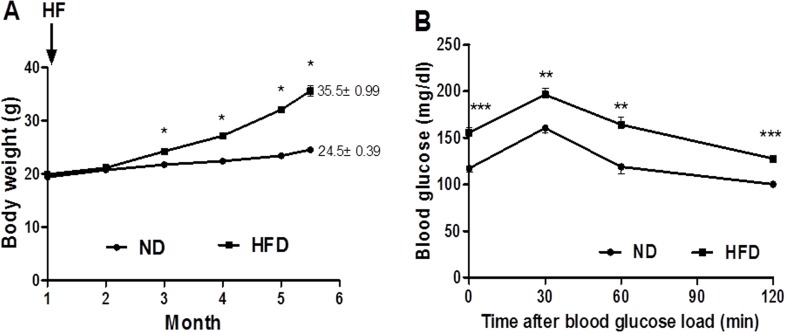
Body weight and metabolic status of mice were affected by HFD.HFD significantly altered the body weight (A), and induced glucose intolerance (B) in C57BL/6J mice. Black circle = Normal diet group, black squares = High-fat diet group. Data are mean ± SEM (n = 6), *p<0.05, **p<0.01, ***p<0.001.